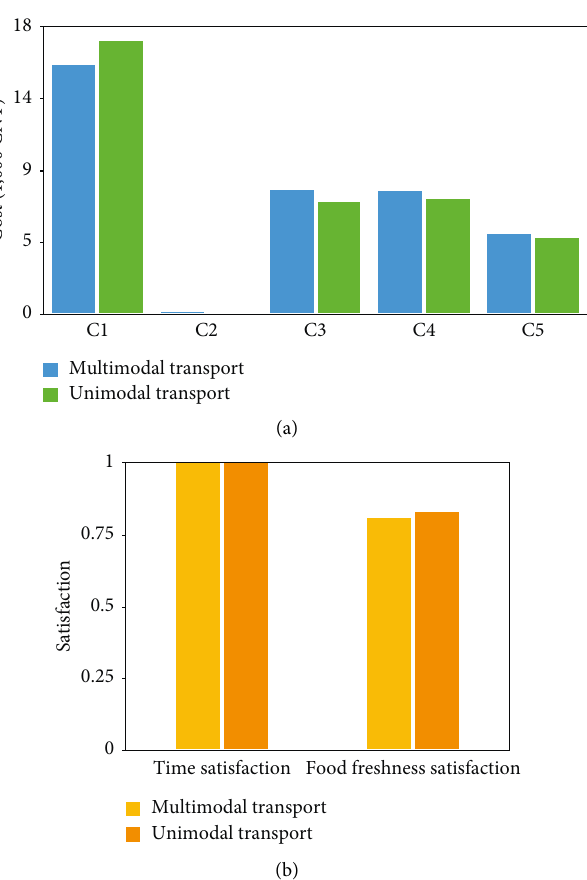
Figure 7: Comparison chart between multimodal transport and unimodal transport. (a) Cost. (b)